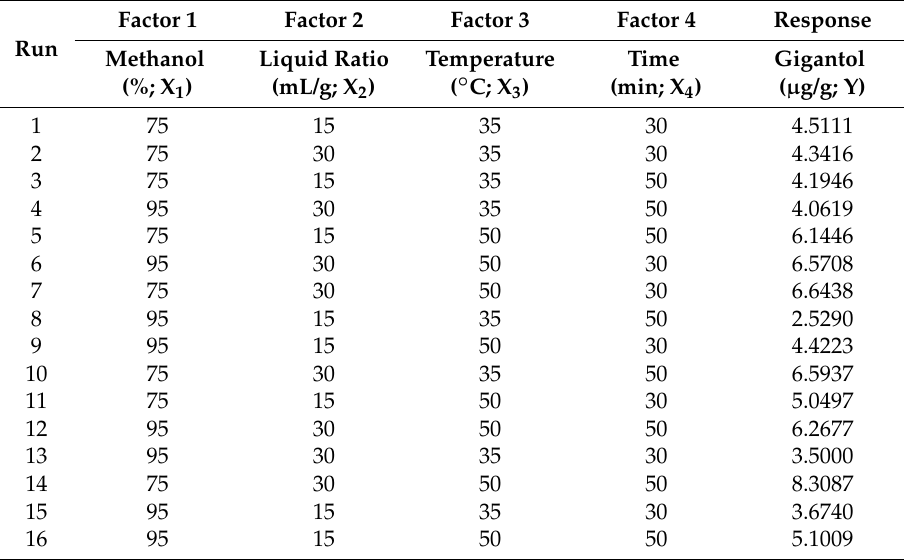
Table 1. Two-level factorial design and results.